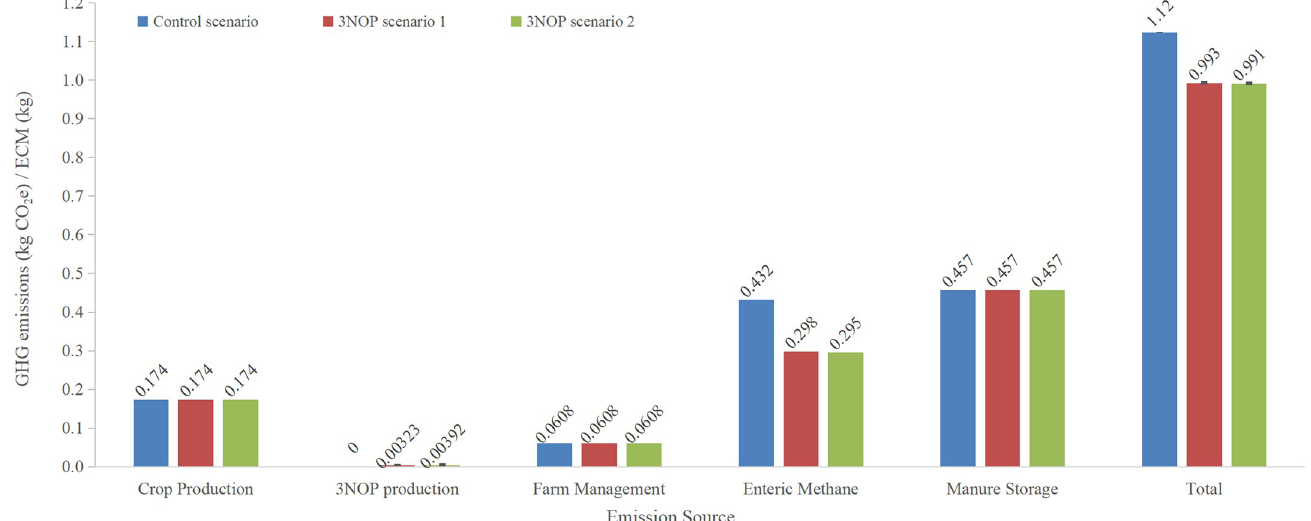
Fig 2. Comparison of global warming potential (GWP) by emission source for control and 3-nitroxypropanol (3NOP) scenarios 1 and 2 in California dairy cows.